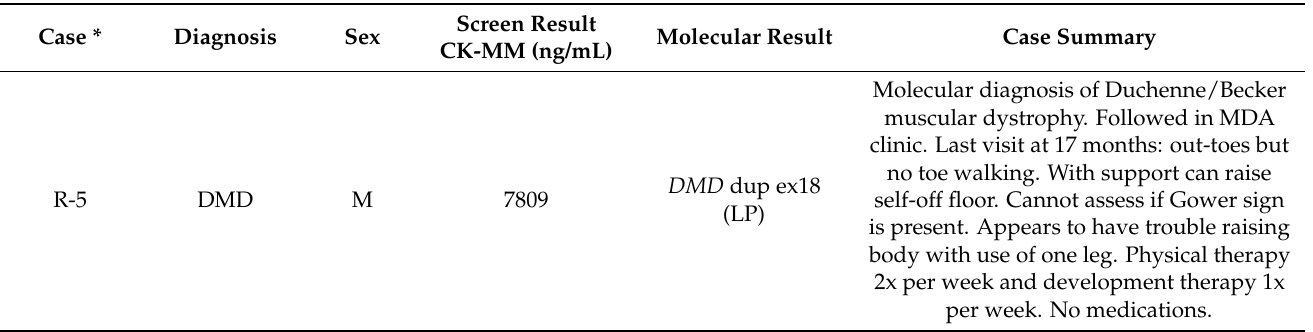
Table 2. Characteristics and results for newborns referred to molecular testing organized by